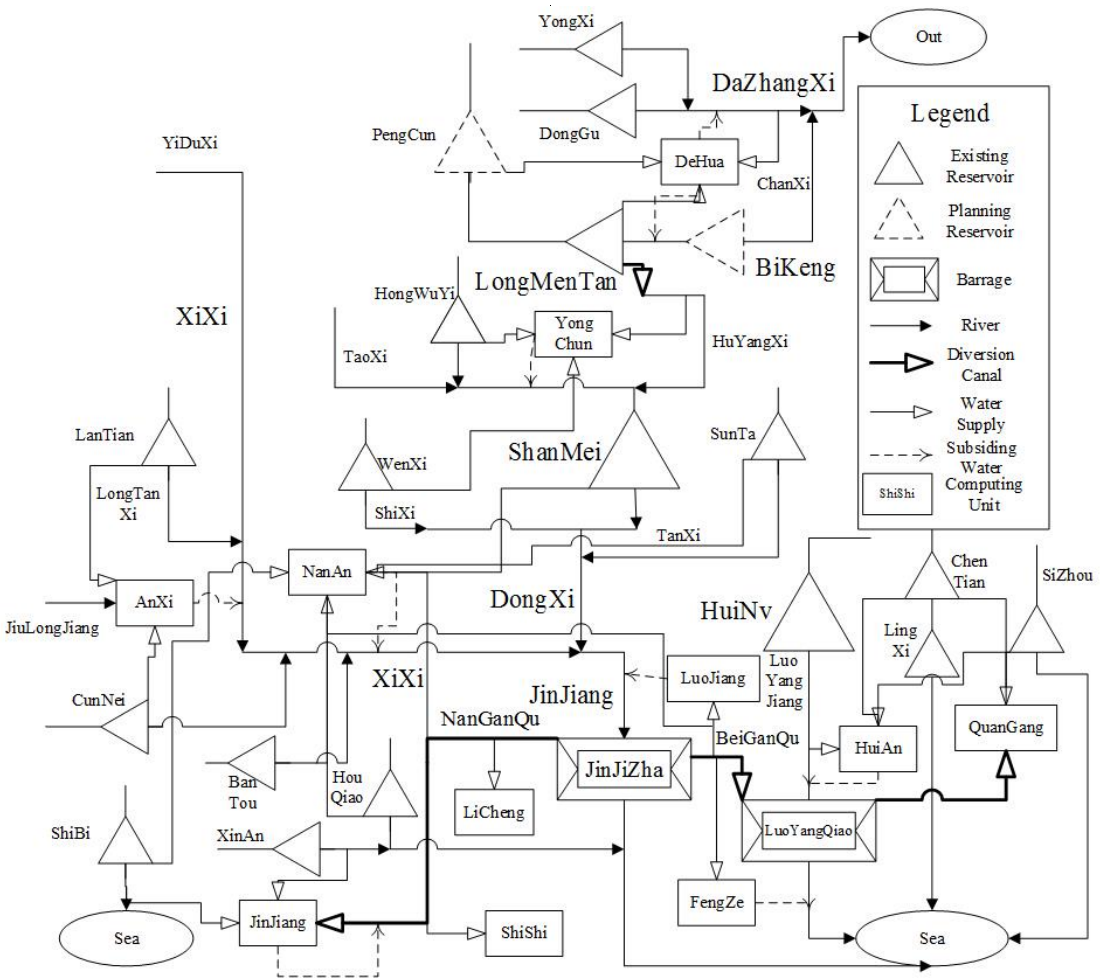
Figure 4. Water resources system of the generalized network for Quanzhou.